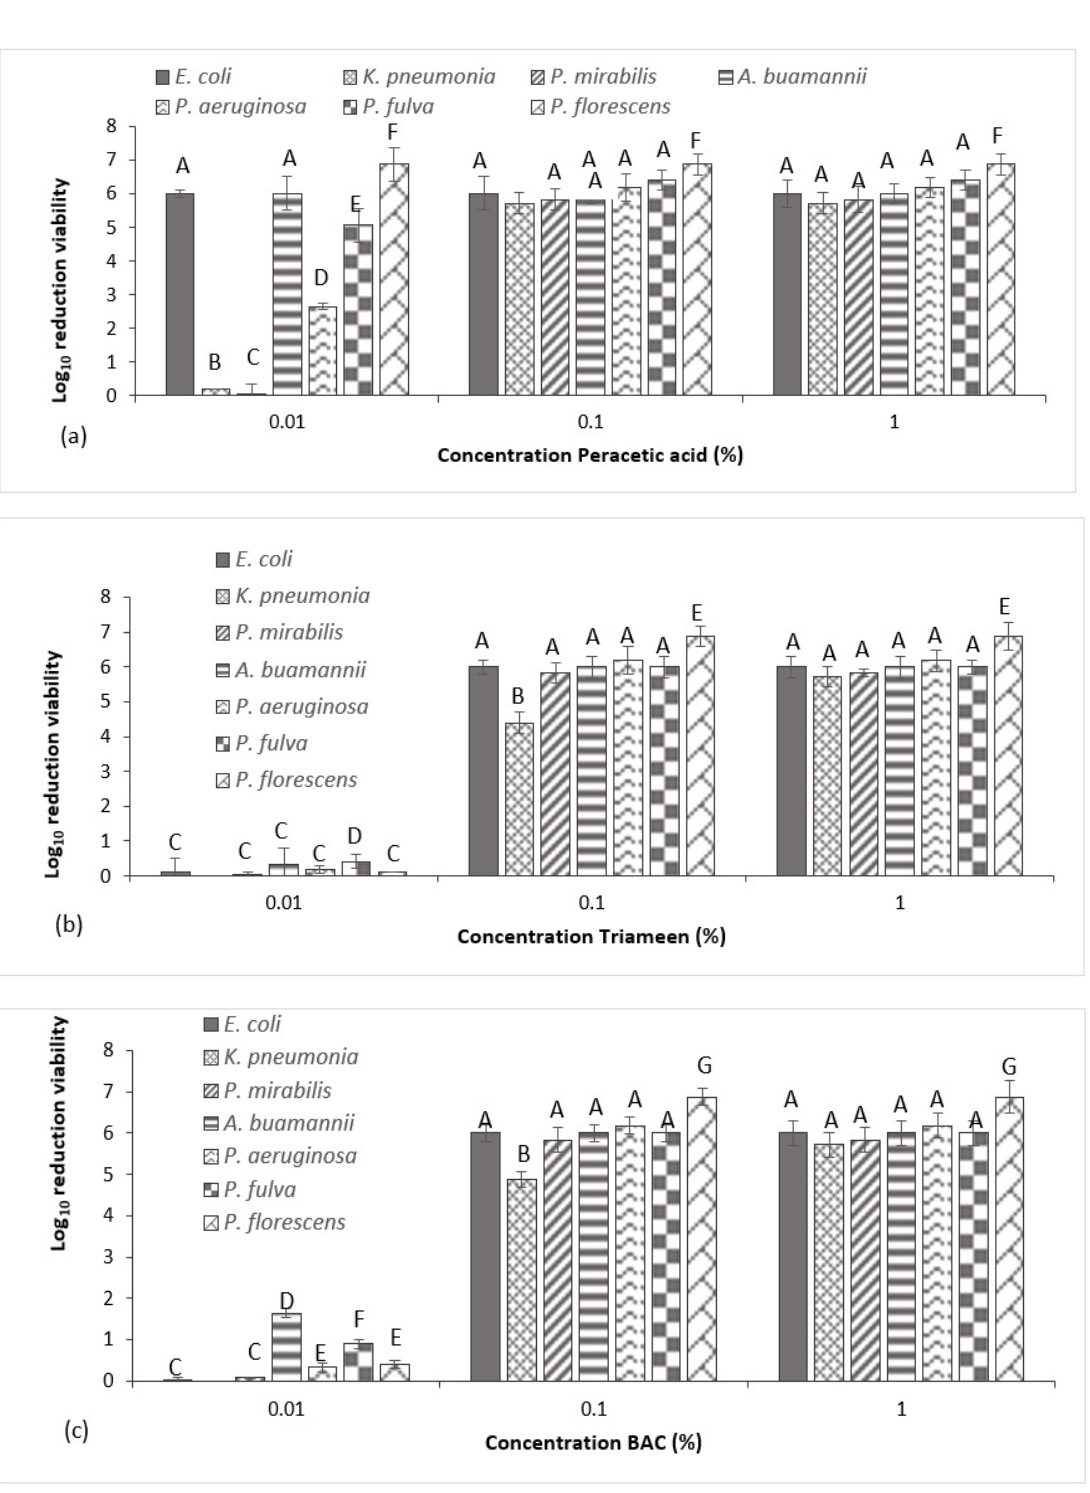
Figure 2. Log 10 reduction in viable cfu/ml of test species as determined by BSEN 1276 following 5 min exposure to 0.01%, 0.1% and 1% ( a ) peracetic acid ( b ) triameen and ( c ) BAC in high interfering solution 10 g/L BSA and yeast extract (+/ − Standard deviation). A, B, C, D, E, F and G denote a significant difference between the strains, where groups displaying the same letter are statistically similar whilst those denoted by a different letter are statistically different.